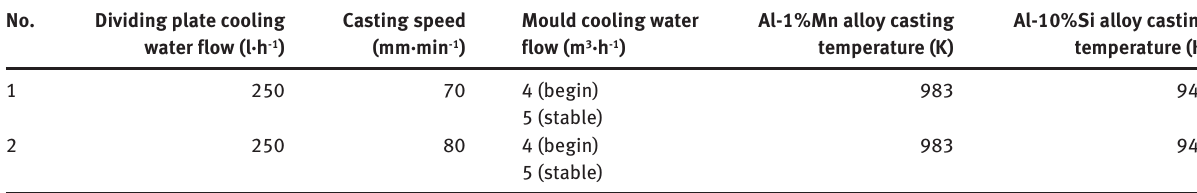
Figure 1: One-half of a symmetrical schematic illustration of continuous casting of clad slab: (1) melt launder, (2) Al-1%Mn alloy melt, (3) Al-1%Mn alloy solidified shell, (4) water-cooled dividing plate, (5) Al-10%Si alloy melt, (6) sprues, (7) mold, (8) semi-solid Al-10%Si alloy, (9) interface, (10) bimetal slab. Table 1: Experimental parameters of the semi-continuous casting. No. Dividing plate